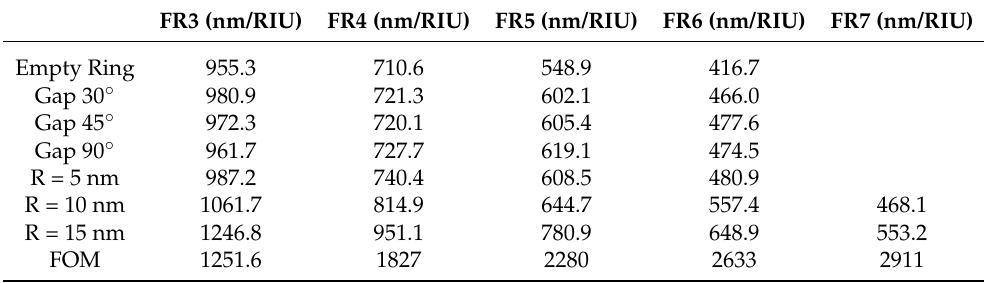
Table 3. Summary of the sensitivity for different order modes in different structures. FOM is presented when r = 15 nm and gap interval is 10 ◦